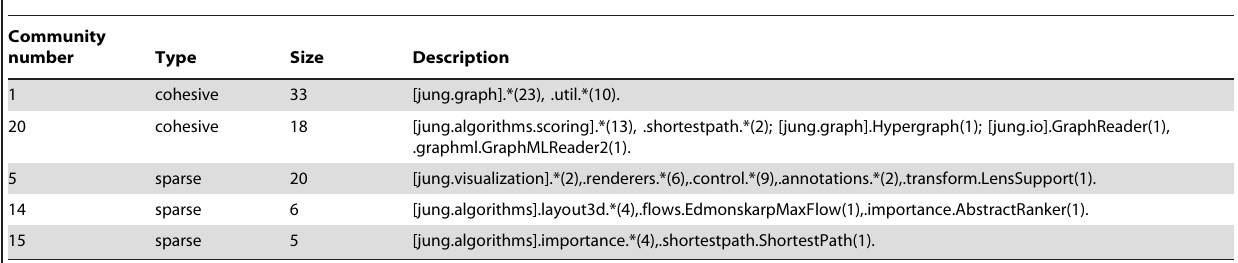
Table 2. Analysis of the main modules in Jung